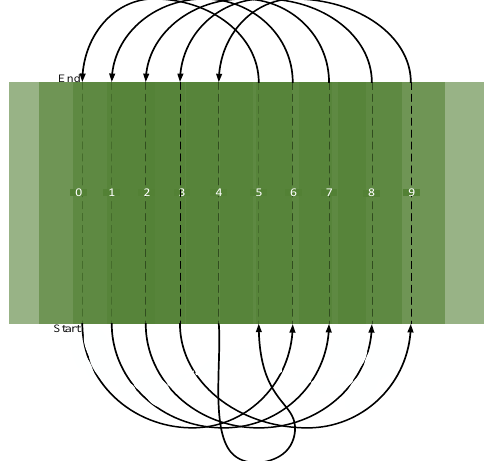
Figure 8. Schematic diagram of regional coverage path planning.